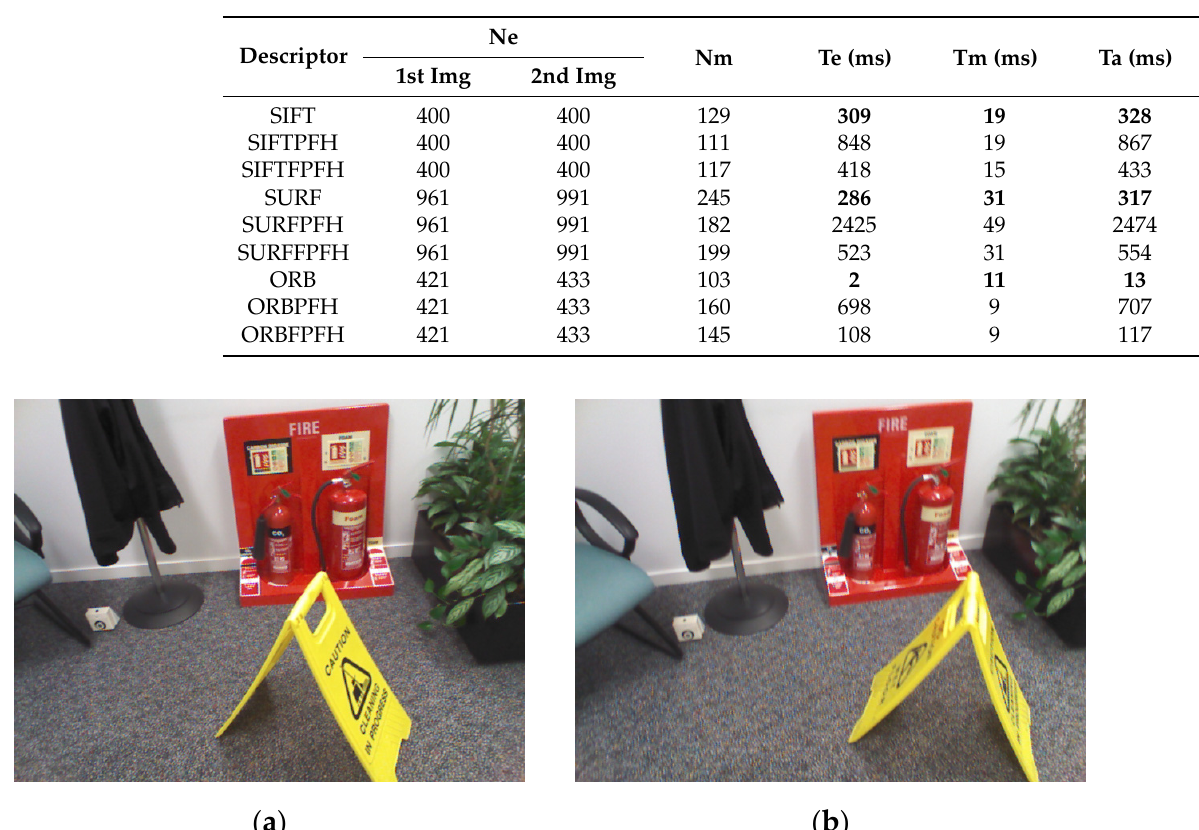
Table 1. Test results of the YCB 0024 dataset.